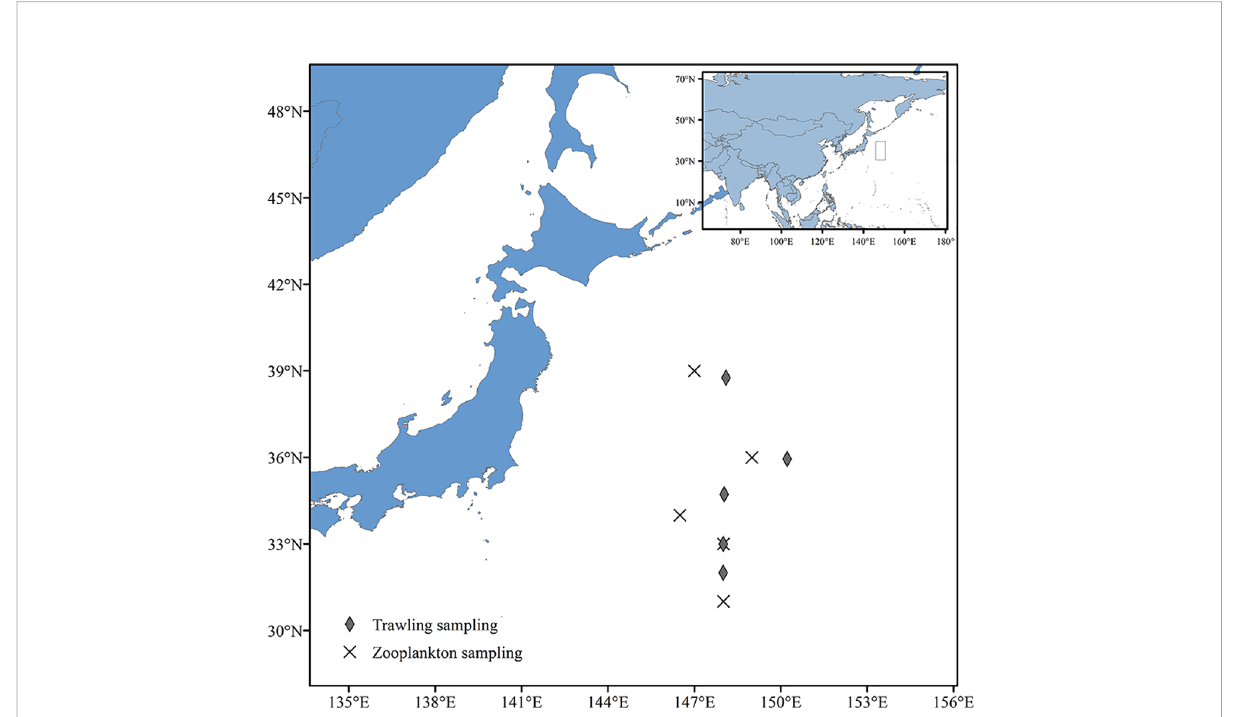
FIGURE 1 Sampling location of zooplankton and micronekton in the Northwest Paci fi c Ocean,